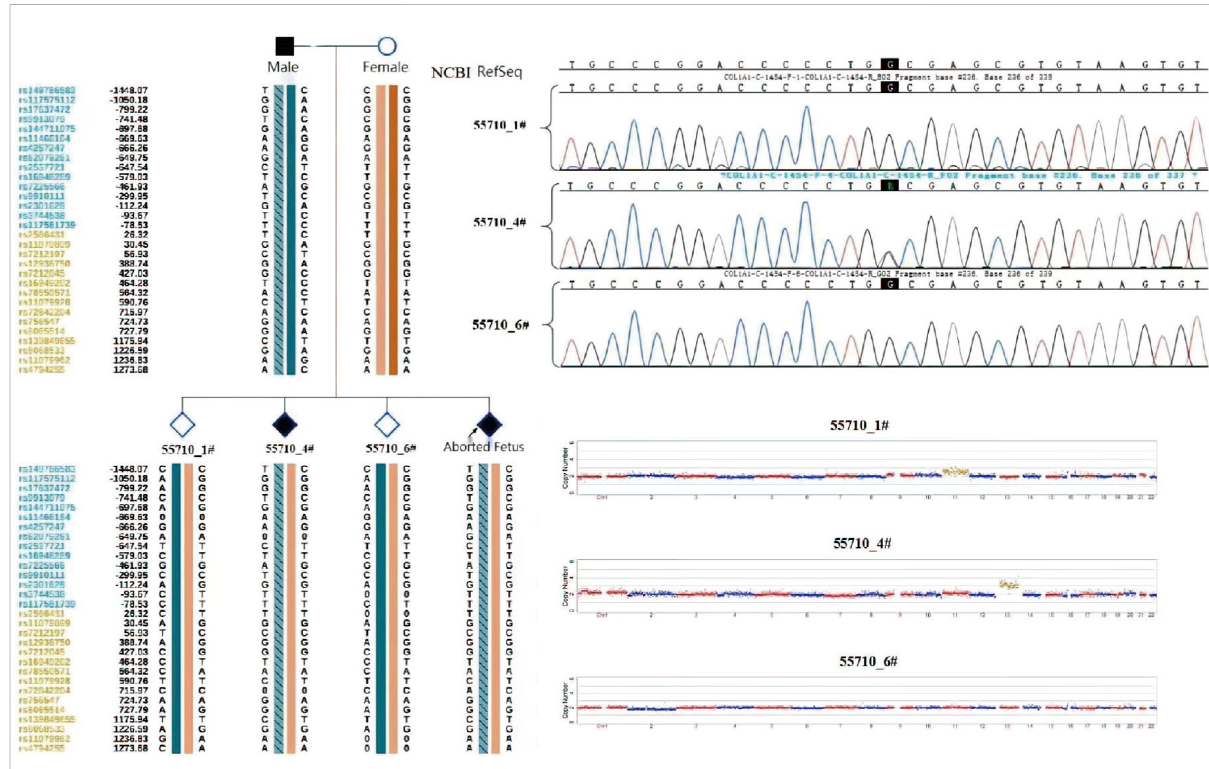
FIGURE 6 Embryo testing results (including haplotype analysiss, sanger sequencing for mutation locus testing and CNV testing, revealed that two of the blastocysts were aneuploid, whereas one was euploid and did not carry the paternal mutation).